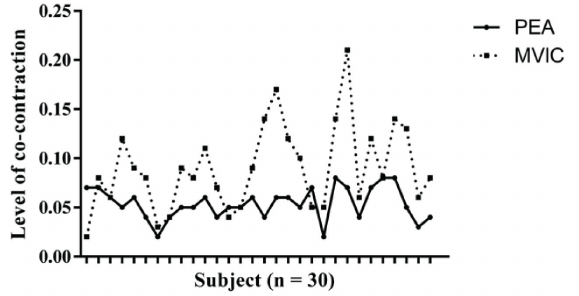
Figure 1 - Variations in vastus lateralis and biceps femoris co-contraction levels during gait, normalized by peak electri- cal activity (PEA) and maximal voluntary isometric contrac- tion (MVIC) (n =